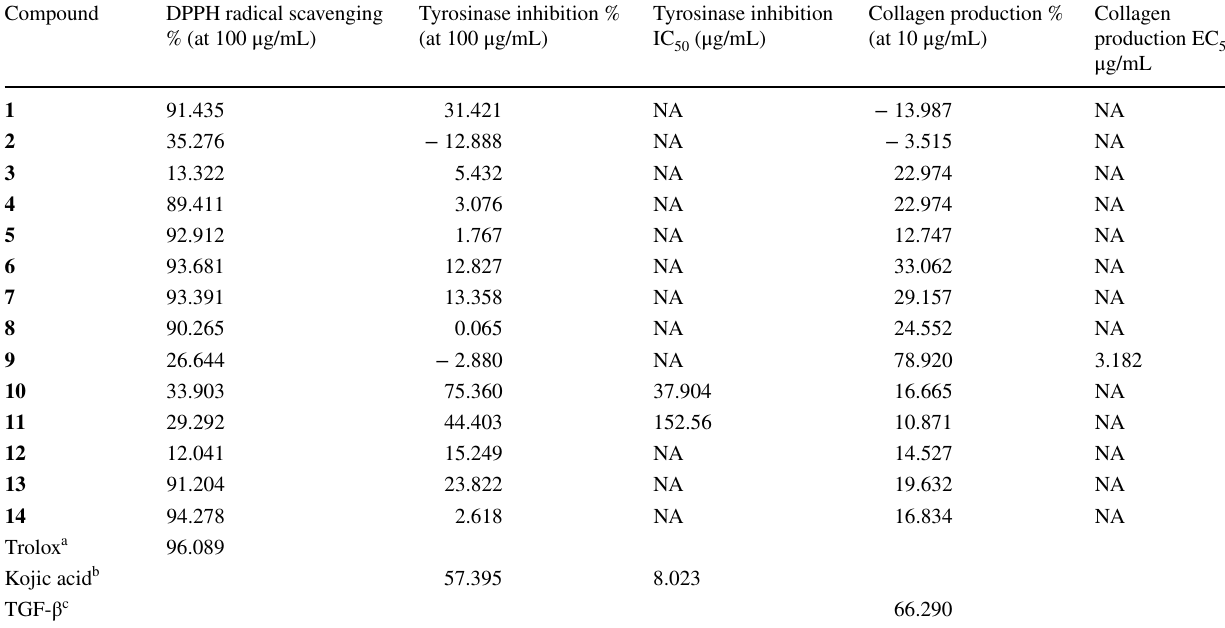
Table 2 Antioxidant, tyrosinase inhibitory and collagen production activities of compounds 1 – 14